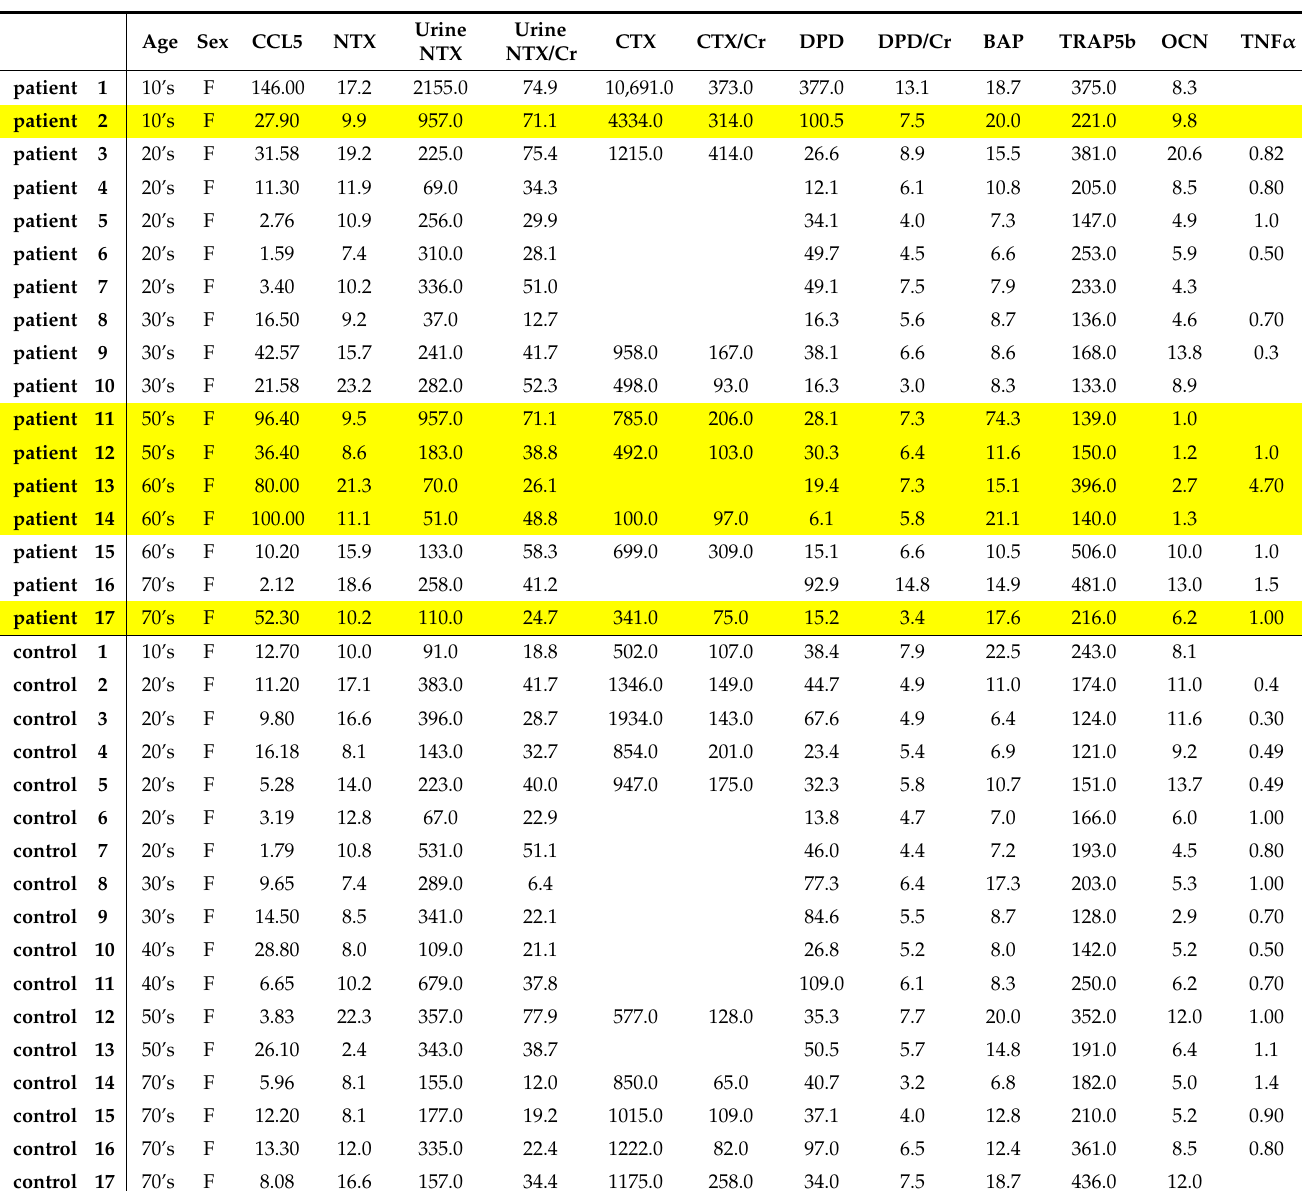
Table 1. List of laboratory results for all DJD-TMJ and control subjects. Highlighted in yellow shows patients with systemic